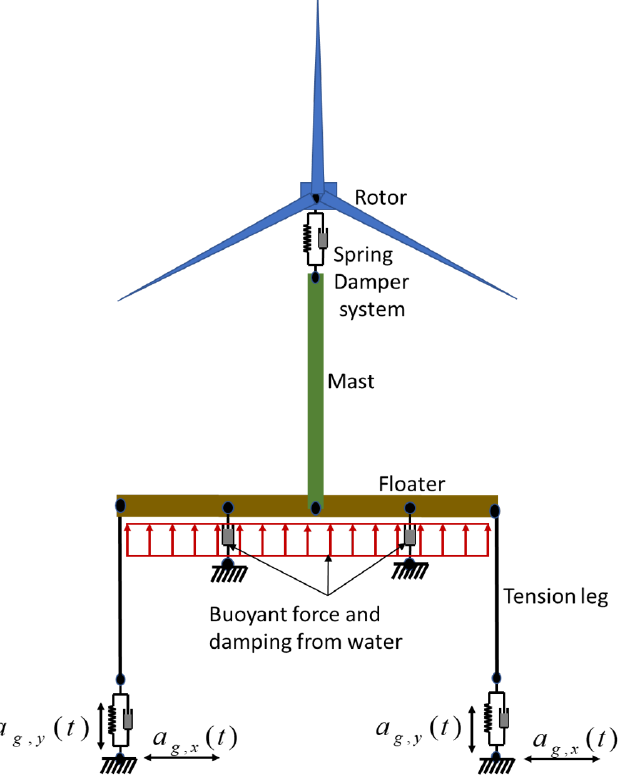
Figure 16. Schematic of the finite element model used for the analysis of TLP wind